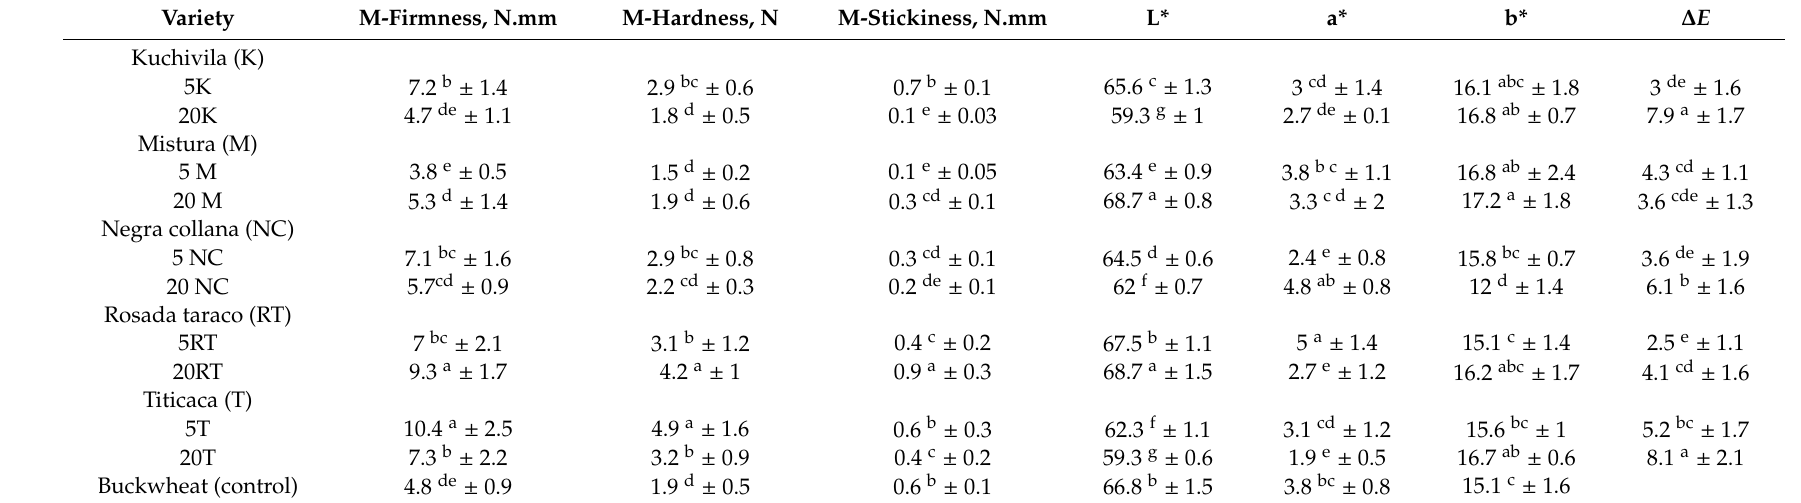
Di ff erent letters indicate significant di ff erence at level p of